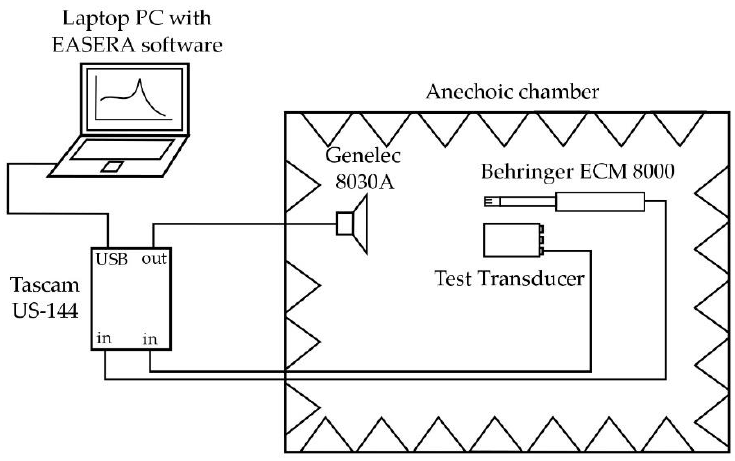
Figure 2. Experimental set up for sensitivity measurements.